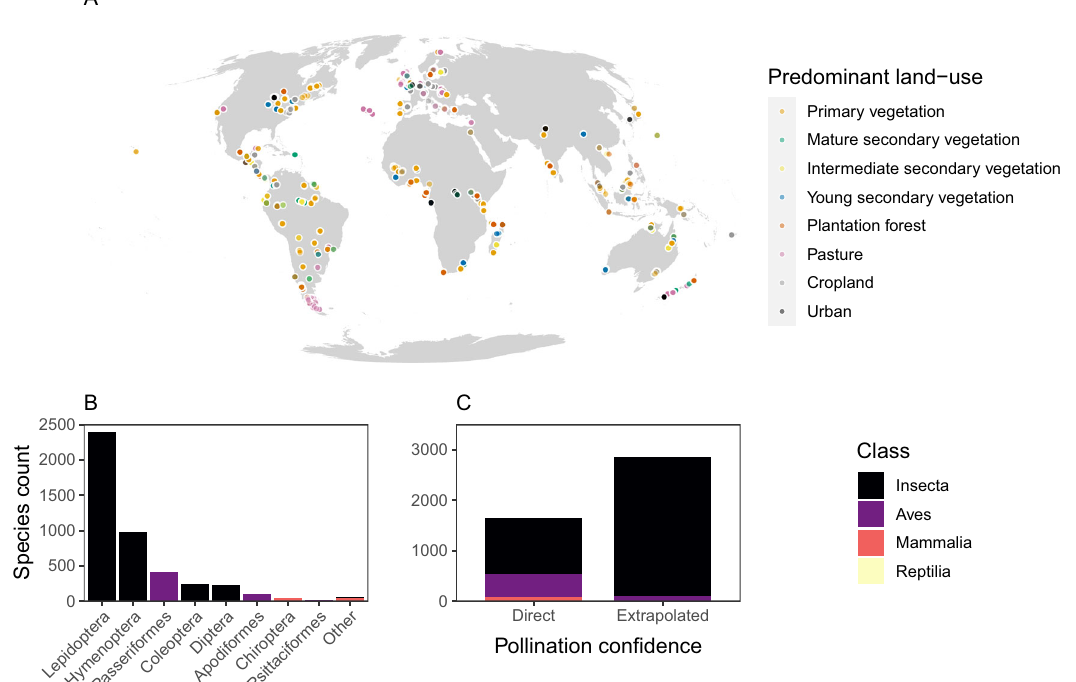
Fig. 1 Data on species in the PREDICTS database identi fi ed as likely pollinators, after automatic text-mining, manual fi ltering, and expert consultation. A The global distribution of PREDICTS sites containing likely pollinating species, for which both the land-use type and intensity of that site are known ( n sites = 8639). Colours represent land-use type: orange (primary vegetation), green (mature secondary vegetation), yellow (intermediate secondary vegetation), blue (young secondary vegetation), dark orange (plantation forest), pink (pasture), grey (cropland), and black (urban). B The taxonomic distribution of likely pollinating species in PREDICTS for all sites ( n species = 4502). The number of species indicated here will be an underestimate of the number of pollinating species in PREDICTS, since this fi gure only includes records for which there is a full scienti fi c binomial in the database. Some biodiversity records in the PREDICTS database are recorded above the level of species. C The source of information (direct evidence at the genus level or extrapolated to groups based on information for groups at higher taxonomic levels) for pollinators in PREDICTS, broken down by taxonomic class. In both B and C , there are four taxonomic classes: Insecta (black), Aves (purple), Mammalia (red), and Reptilia (yellow). The reptiles are represented by only 5 species with ‘ Direct ’ con fi dence (see Supplementary Table 2).